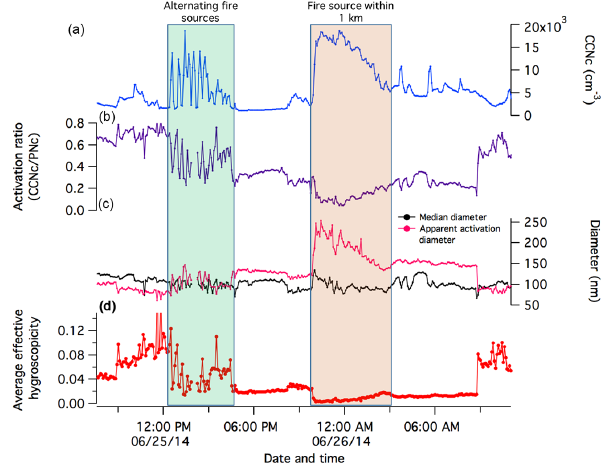
Figure 6. The CCNc, activation ratio, median particle diameter, ap- parent activation diameter and average effective hygroscopicity pa- rameter during two periods with close-proximity ( < 1km) fires. The green shaded area indicates the period where the wind direction was periodically changing between southeasterly and northeasterly. The red shaded area indicates the period where emissions were from a grass fire burning less than 1km from the sampling